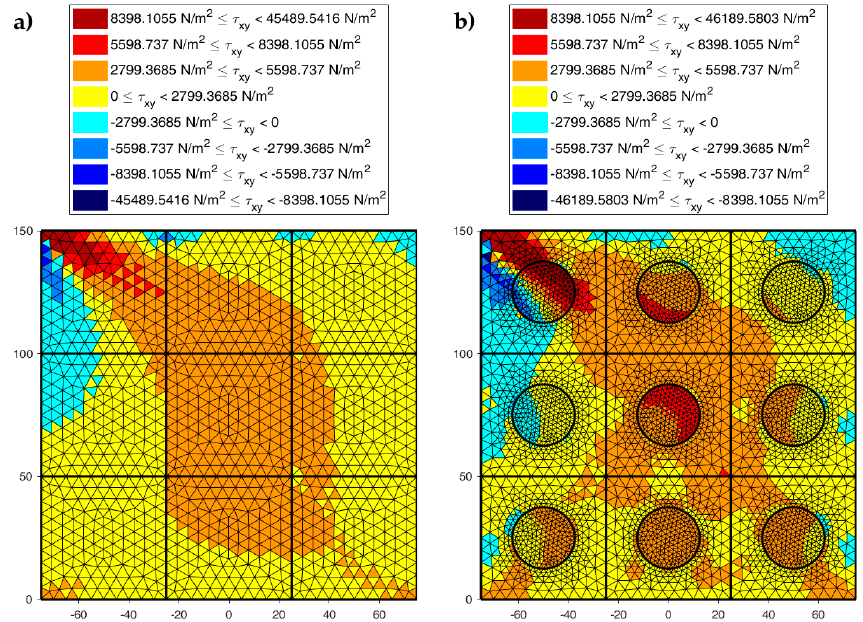
Figure 24. Shear stresses τ xy in the discrete elements of a 3 × 3 array subjected to shear load: ( a ) Without inclusions and ( b ) with round inclusions, which are sti ff er than the matrix.